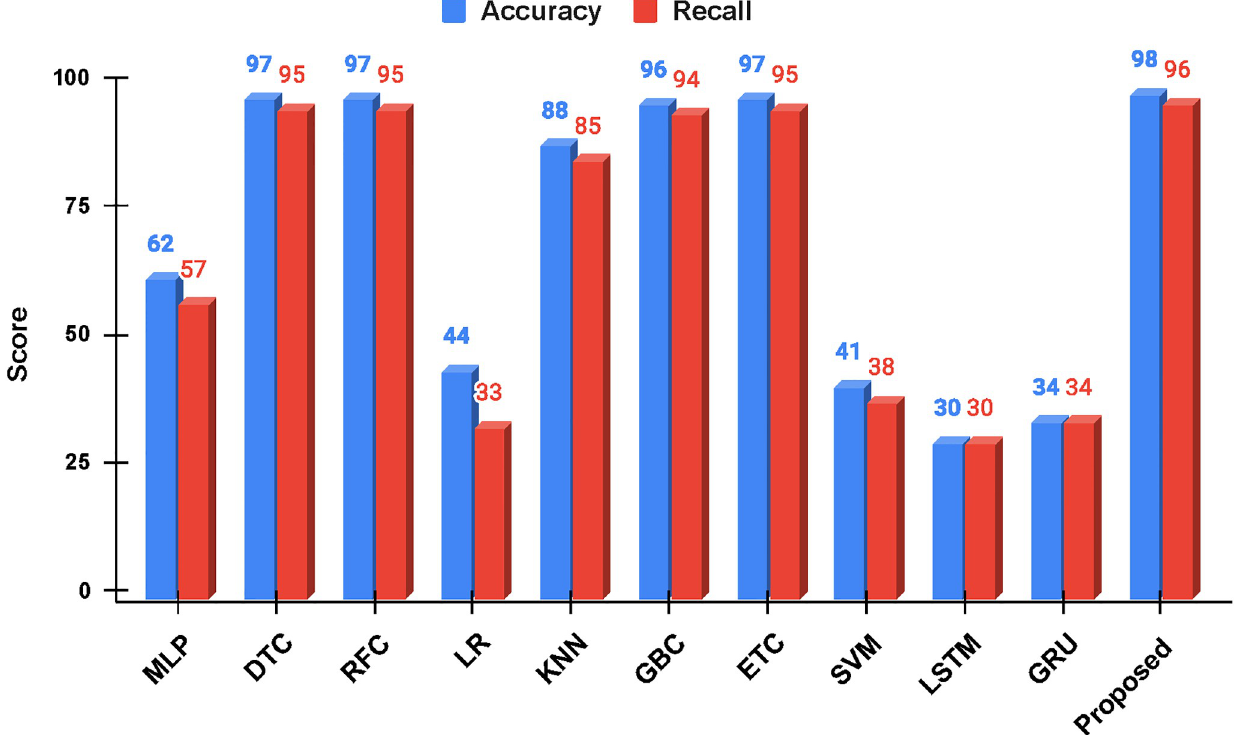
Fig 7. Comparative analysis of employed machine learning and deep learning models in terms of accuracy and recall.